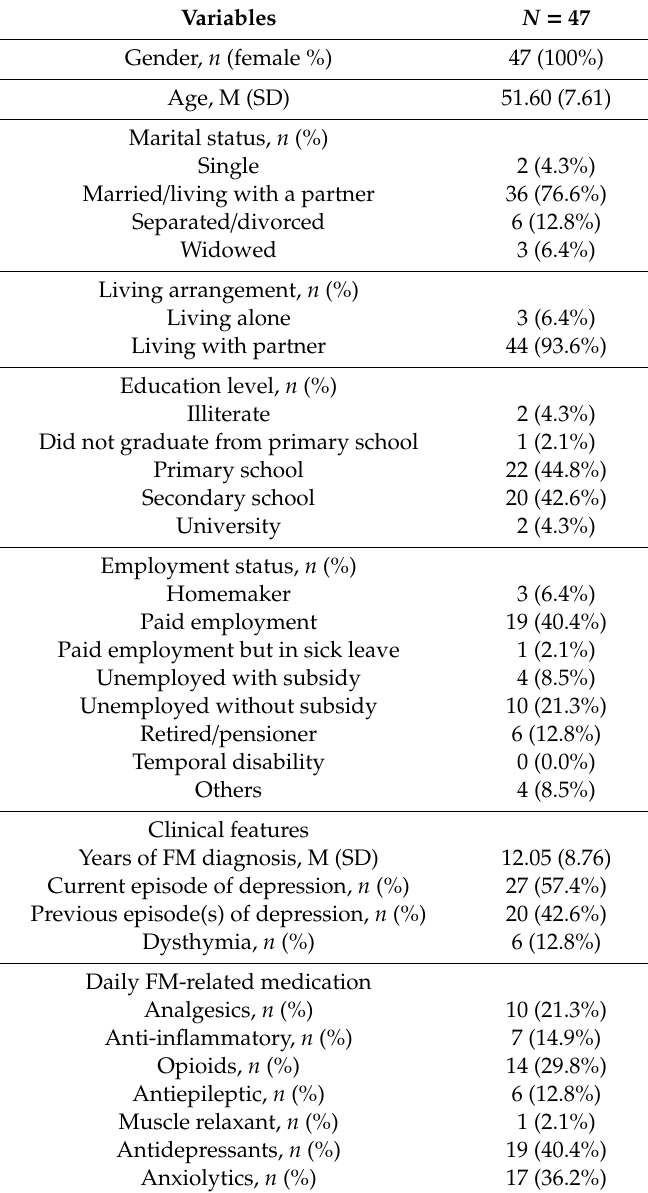
Table 1. Sociodemographic and clinical characteristics of the study